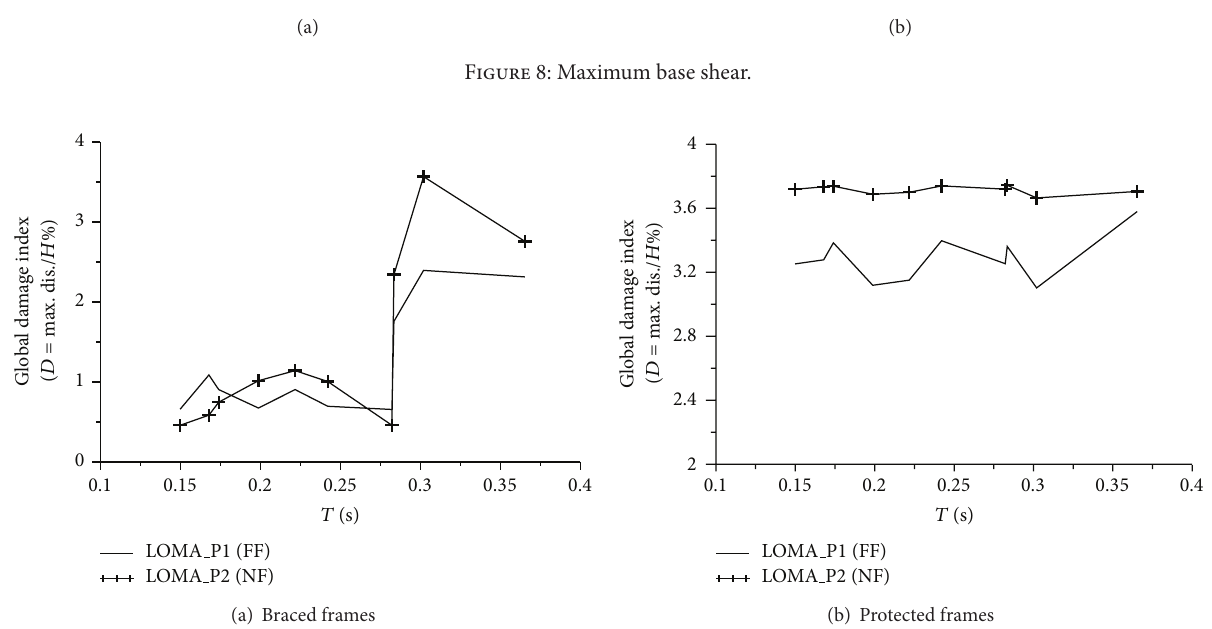
Figure 8: Maximum base shear.